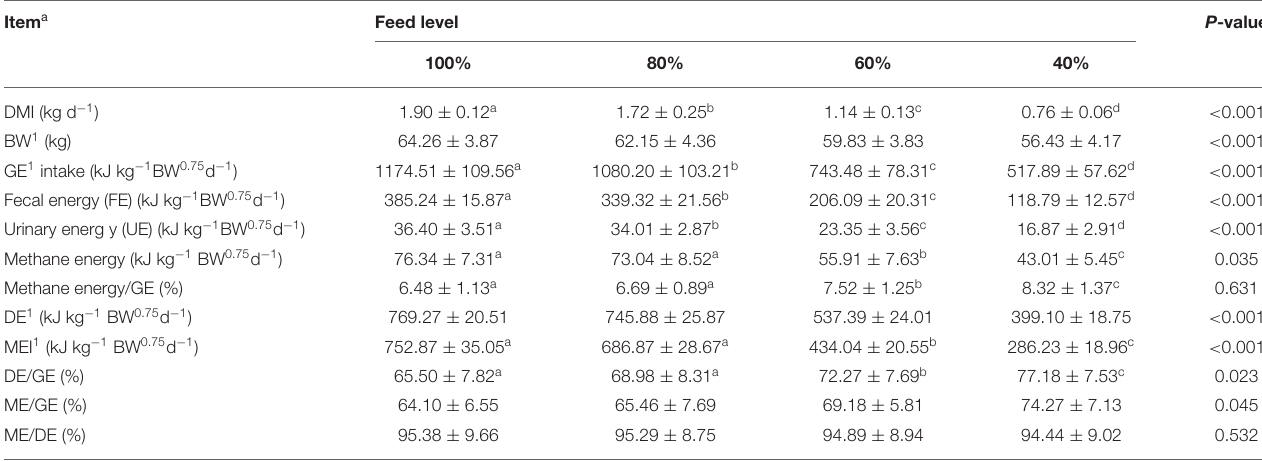
TABLE 2 | Effect of feed intake on body weight, dry matter intake (DMI), and energy balance in the digestion and respirometry tiral. Item